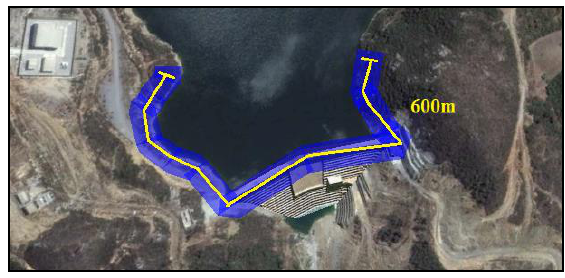
Figure 8 . Study area for MDL and TLS comparison